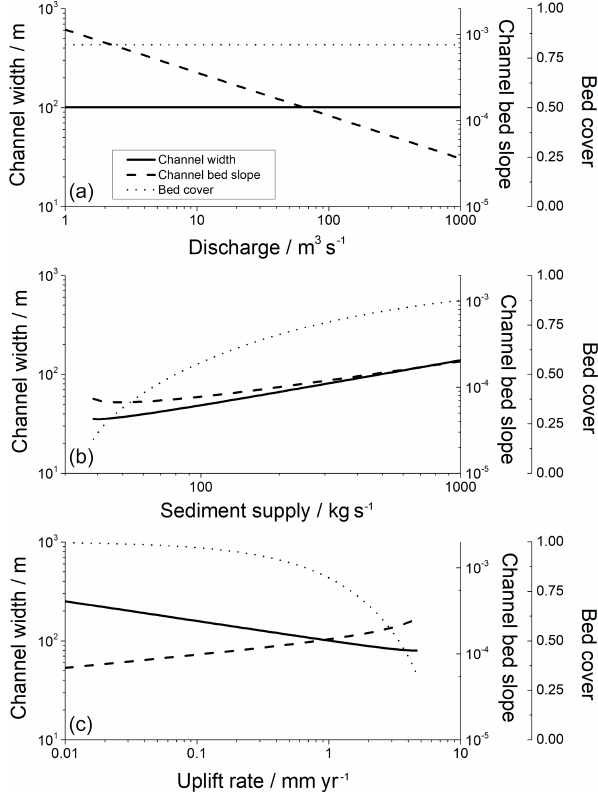
Figure 4. Steady-state channel width (solid line), channel bed slope (dashed line), and bed cover (dotted line) against forcing variables discharge (a) , sediment supply (b) , and uplift rate (c) . For the cal- culations, all other parameters have been kept constant (Table